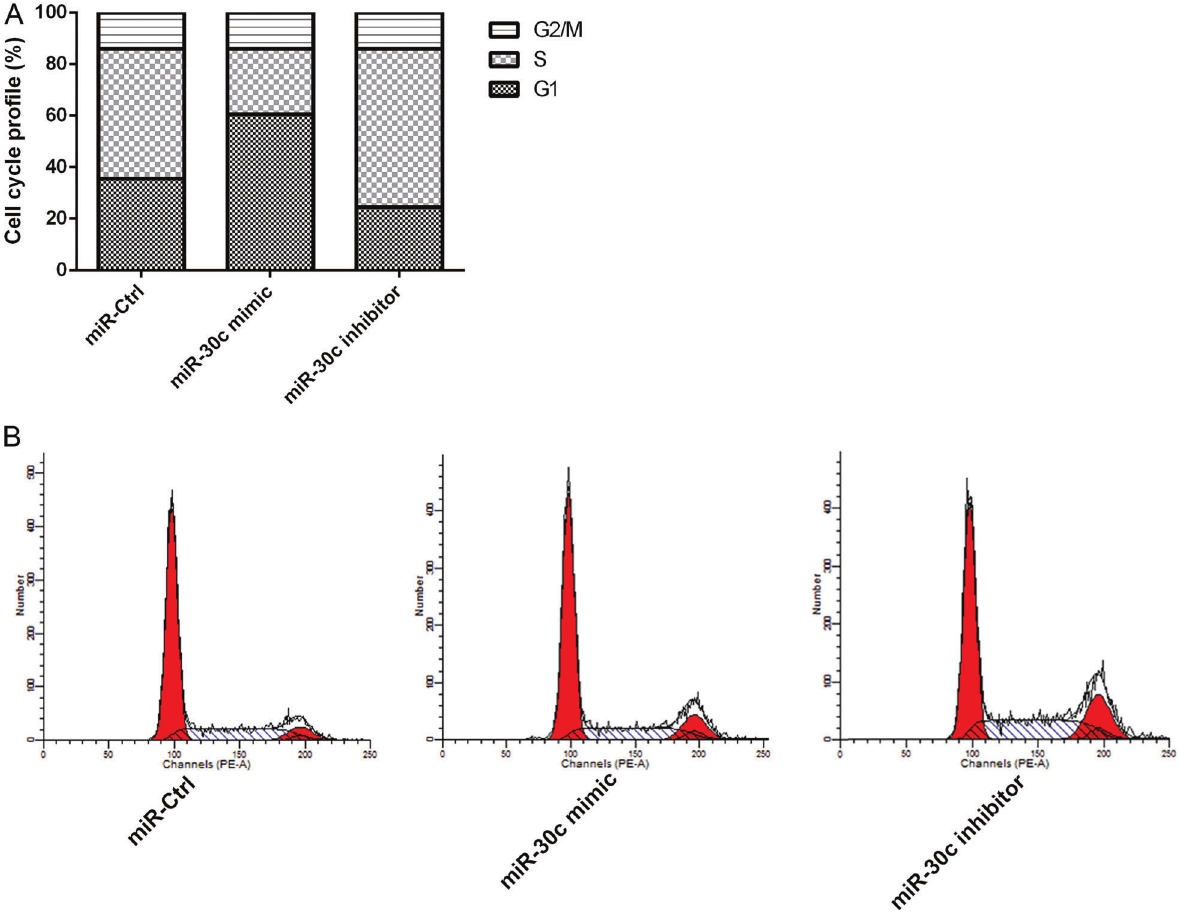
Figure 4. Overexpression of miR-30c induced G1/S cell cycle arrest in hepatoma